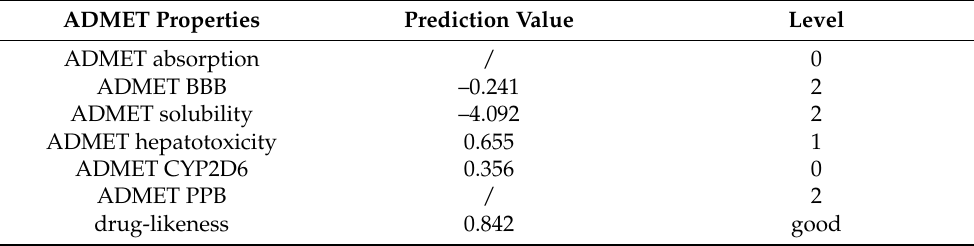
Table 3. Predicted ADMET properties of AM [27].